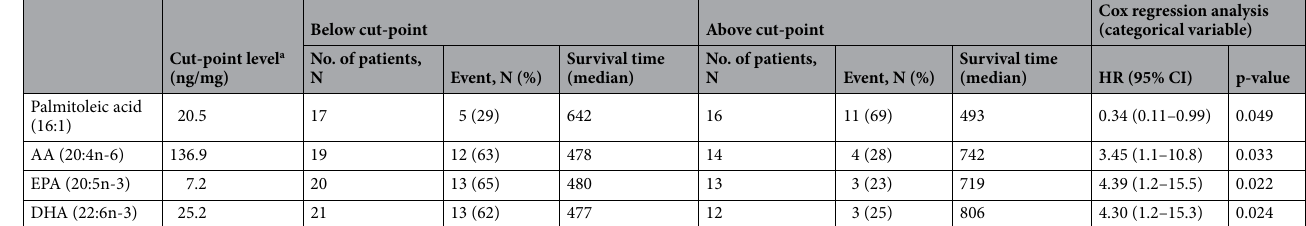
Table 3. Deaths, the median number of days of survival and odds ratio for fatty acids below or above level of skeletal muscle phospholipid fatty acids in cancer patients. AA arachidonic acid, DGLA Dihomo-gamma- linolenic acid, DHA Docosahexaenoic acid, EPA Eicosapentaenoic acid. a Cut-points were defined by optimum stratification. BMI, tumor site, metastasis and age were not significant predictors of number of days of survival.